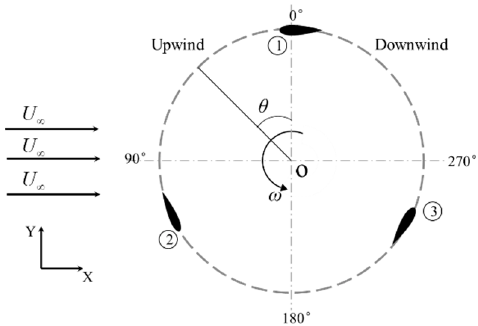
Figure 2. Position of each blade of VAWT. Figure 3. Position of the plasma actuator on a blade.